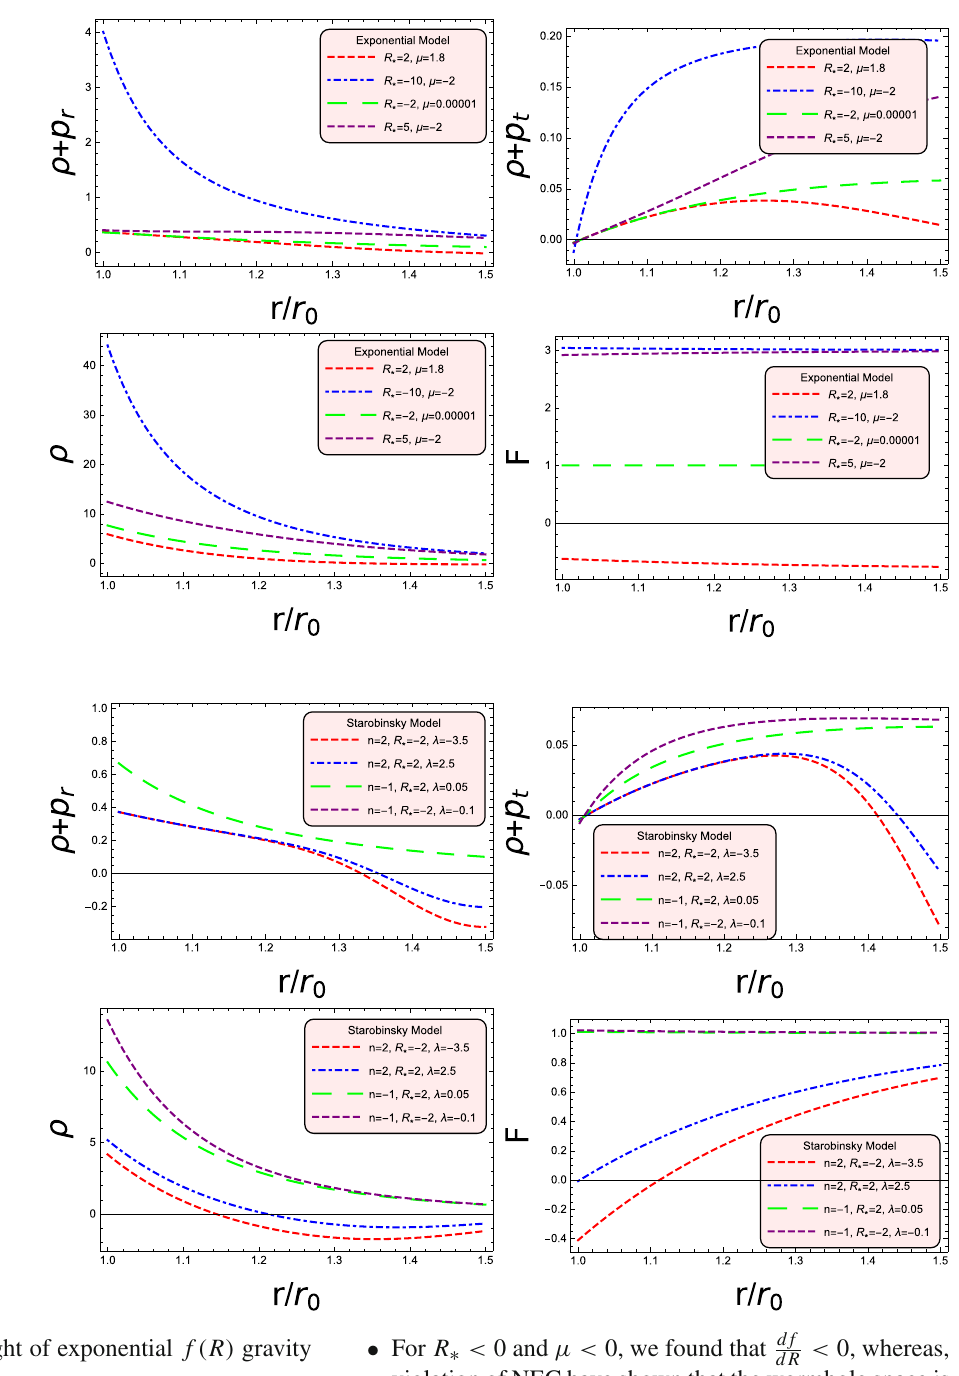
Fig. 5 The both terms of NEC ρ + p ρ + p r (upper left) and t (upper right) are respected at the throat for wormhole geometry for all the considering combinations of free parameters. The first term of WEC ρ (lower left) also shows the validation at the throat. While, we get the violation of non-existence theorem when μ > 0, R ∗ > 0 (lower right)